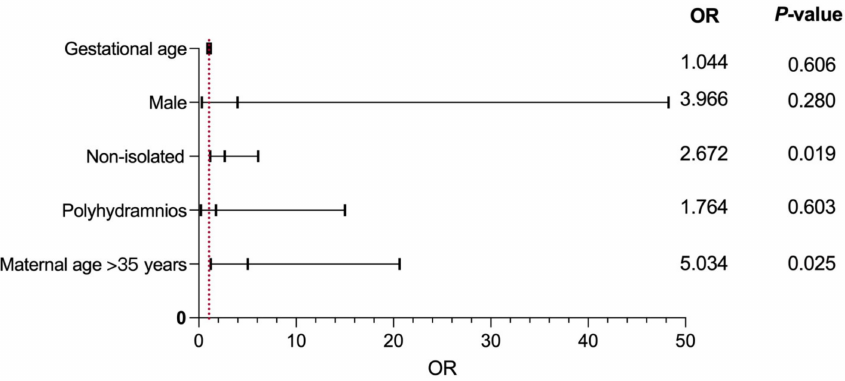
Figure 2. Binary logistic regression analysis of factors leading to the predictors of adverse pregnancy outcomes of PA. OR, odds